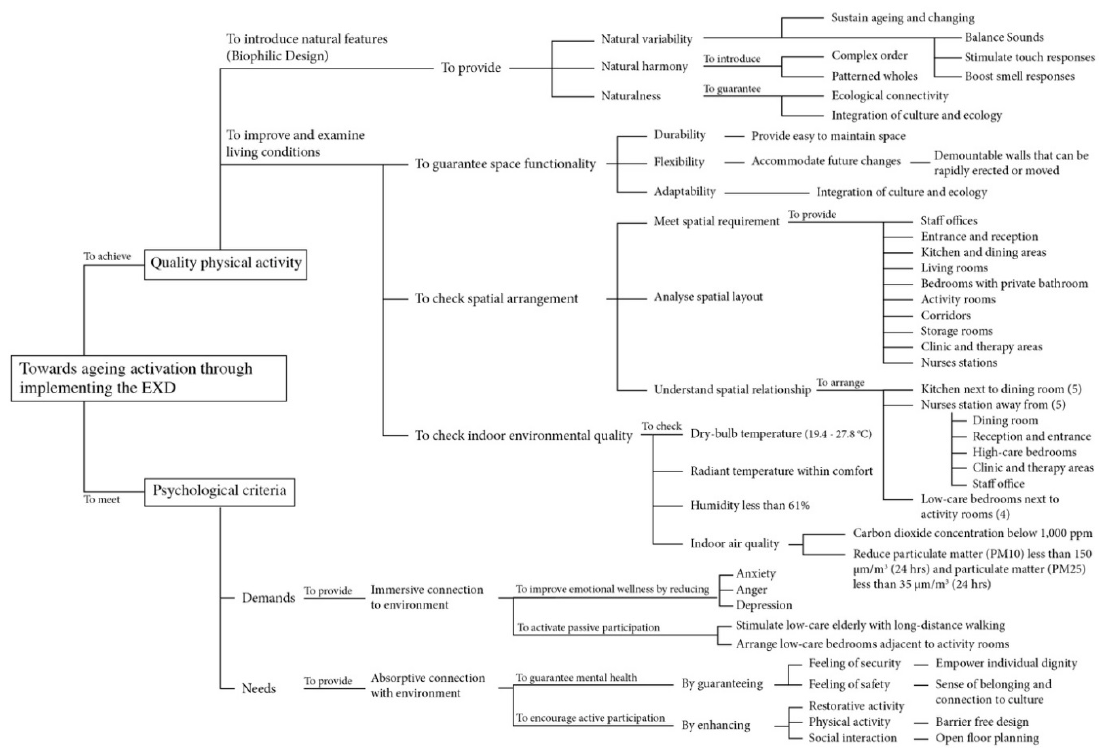
Figure 7. EXD FAST diagram of senior residents’ physical and metaphysical functions. Based on the observations of the spatial settings throughout the ground floor, level differences are well avoided, and this inclusive design fundamental allows for enhanced accessibility and safety of the senior users with mobility aids. Partitions set between the dining and kitchen area tend to discourage visual and physical interaction, while limiting the circulation of unfavourable smells. Staff areas, including the office, reception, and nurses’ station are located next to the dining room, which serves as the residents’ social activities. The bedrooms were dimensionally adequate and were lit by natural light coming through the transparent window that is centered in the external wall. Outdoor spaces are equipped with accessible garden pedestrian paths, communal spaces with barbeque facilities, visually stimulating artefacts, and seasonal plants—those that to some extent contribute to the creation of atmosphere that supports the notion of active aging. Based on the spatial setting observation and FAST diagram results, an EXD evaluation matrix was developed with the aim of identifying the potential upgrading solutions that reflect the Victorian government’s active ageing agenda (Table